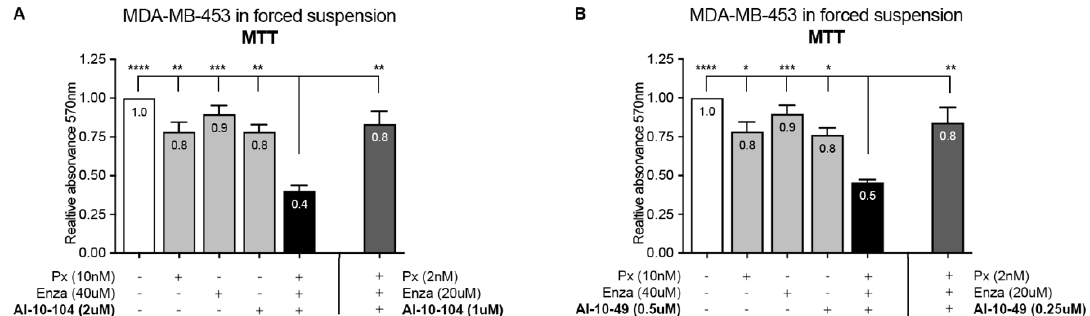
Figure 6. Reduction of RUNX1 transcriptional activity enhances enzalutamide and paclitaxel treatment in CSC-like cells. MDA-MB-453 cells were cultured for 72 h in forced-suspension and treated with either 10 nM Px, 40 µ M Enza and 2 µ M AI-10-104 ( A )/0.5 µ M AI-10-49 ( B ) or the doses used for attached conditions (dark gray bar): 2 nM Px, 20 µ M Enza and 1 µ M AI-10-104 ( A )/0.25 µ M AI-10-49 ( B ) for 72 h. Cell viability was determined by MTT and the results are expressed as the relative absorbance (570 nm) to control treatment (DMSO, 1.00). Statistical differences are shown for the combination of the 3 drugs (black bar) vs. the rest of the treatments (gray bars) or vehicle (white bar). For more details see Suppl Table S3. One-way ANOVA with Tukey multiple comparison was performed from three independent experiments, * p < 0.05, ** p < 0.01, *** p < 0.001, and **** p < 0.0001.